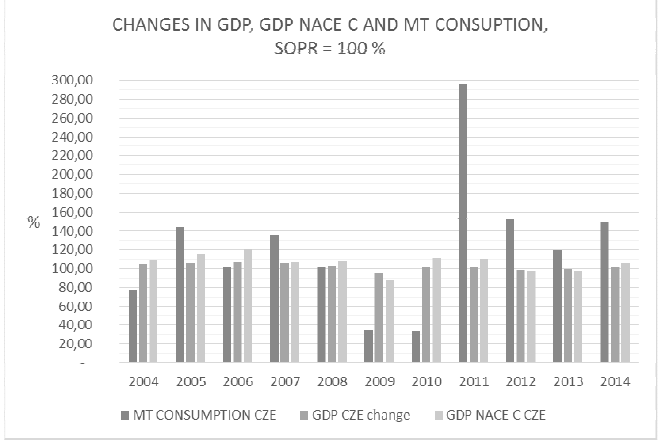
Fig. 8 - Annual changes in the country’s GDP, industrial production and consumption MT in the Czech Republic from 2004 to 2014, constant prices. Source: CZSO, (2017) . Association of Engineering Technology: Reports on the state of Machine Tools Branch in the Czech Republic 2007 -